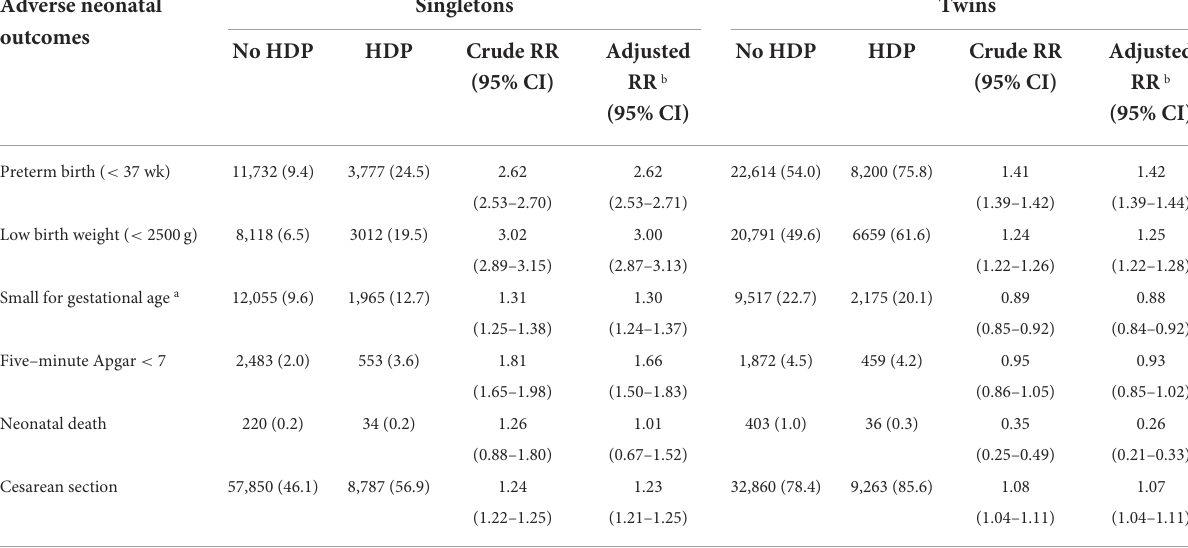
TABLE 2 Association between HDP and adverse neonatal outcomes by plurality in ART